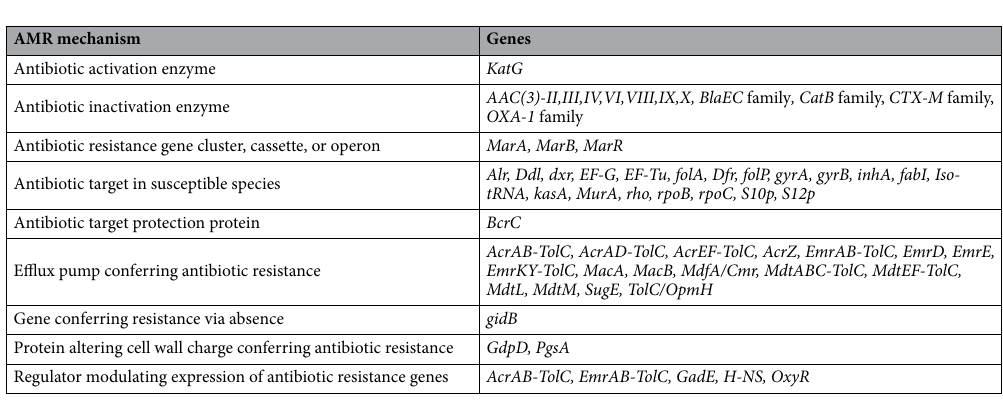
Table 3. AMR genes of L16 annotated in